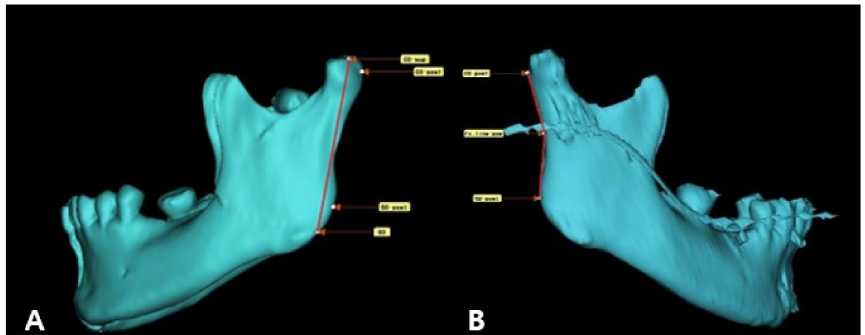
Figure 5. Ramus height and angle of dislocation measured on 3D simulation. ( A ) Pre-operative mandible. ( B ) Post-operative mandible. CO-sup (condylion superius): The most superior point of the condylar head. CO-post (condylion posterius): The most posterior point of the condylar head. GO-post (gonion posterius): The most posterior point on the mandibular angle.